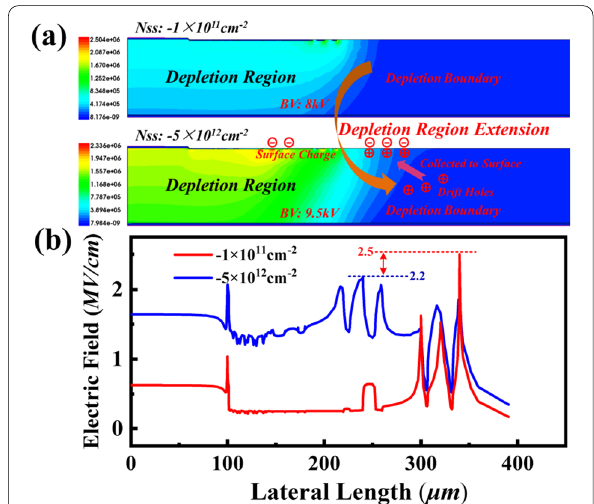
Fig. 5 Simulated electric field distributions of SiC PiN with surface negative charge density of 1 electric field distribution with the depletion region evolution b electric field cutline below the JTE/n-drift region junction. The implant concentration is used 6